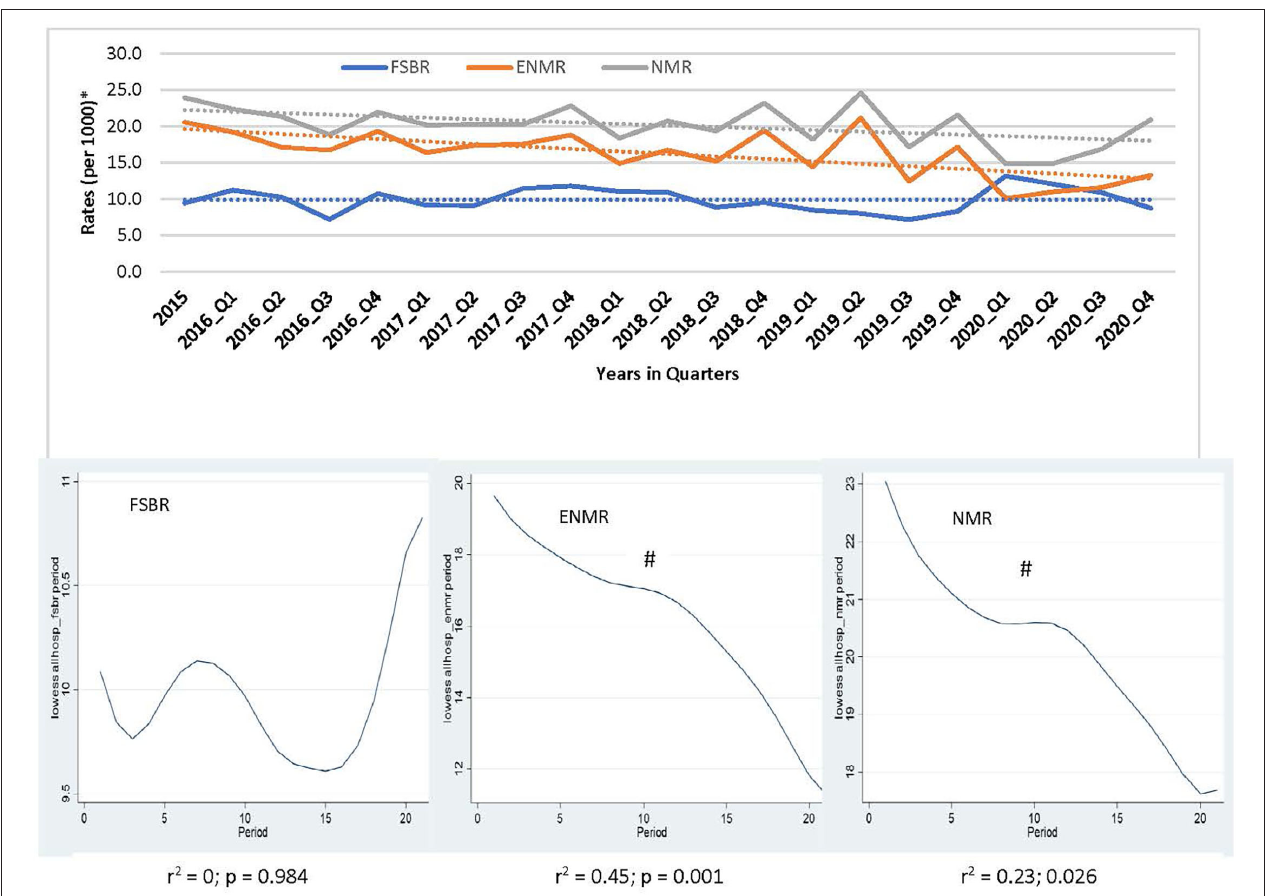
FIGURE 2 | Trends in fresh stillbirth rate (FSBR), early neonatal mortality rate (ENMR), and neonatal mortality rate (NMR), with locally weighted scatterplot smoothing (LOWESS) regression analysis in the lower panel of the Figure for all hospitals combined (Hospitals A to E). # Statistically significant reduction ( p < 0.05). * Per 1,000 total births for fresh stillbirth rates (FSBR) and per 1,000 live births for early neonatal mortality rate (ENMR) and neonatal mortality rate